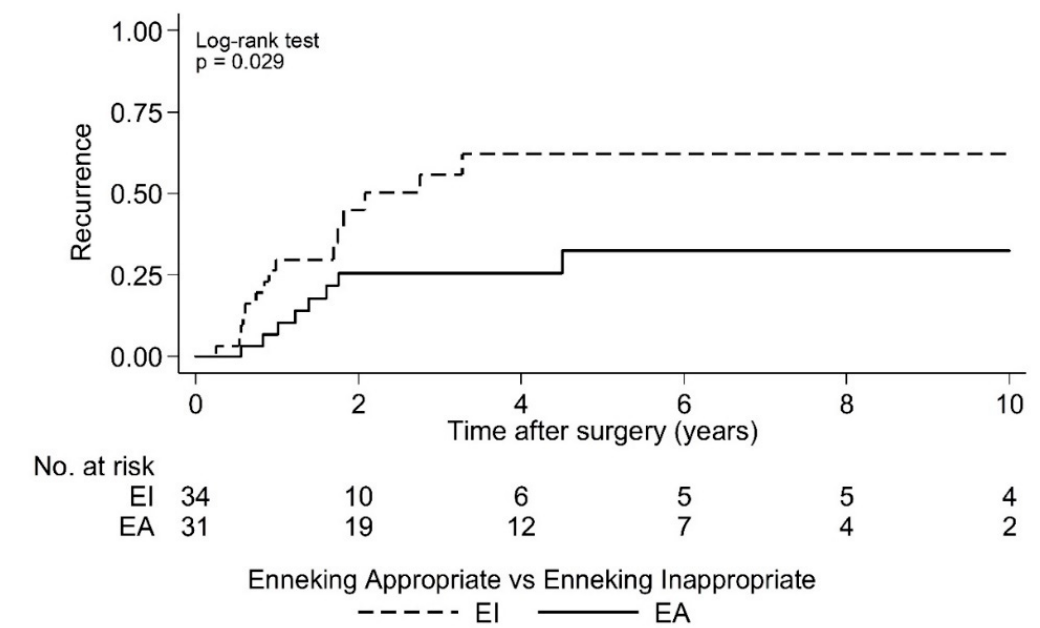
Figure 3. Kaplan-Meier analysis of time to first local recurrence by Enneking appropriateness. EI: Median time to first local recurrence = 2.1 years postoperative [95% CI 1.7, -]; EA: Median time to